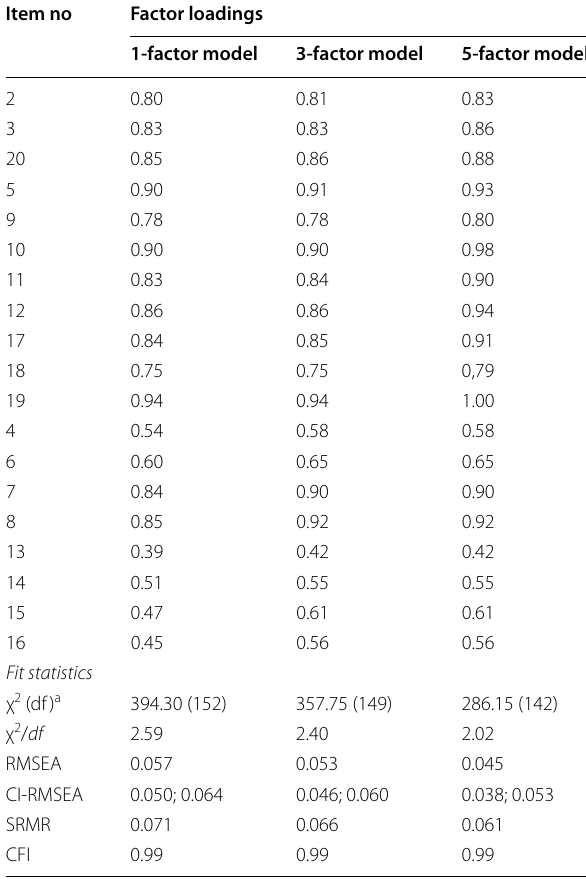
Table 2 Factor loadings and goodness-of-fit-statistics of the CFA on three models of the